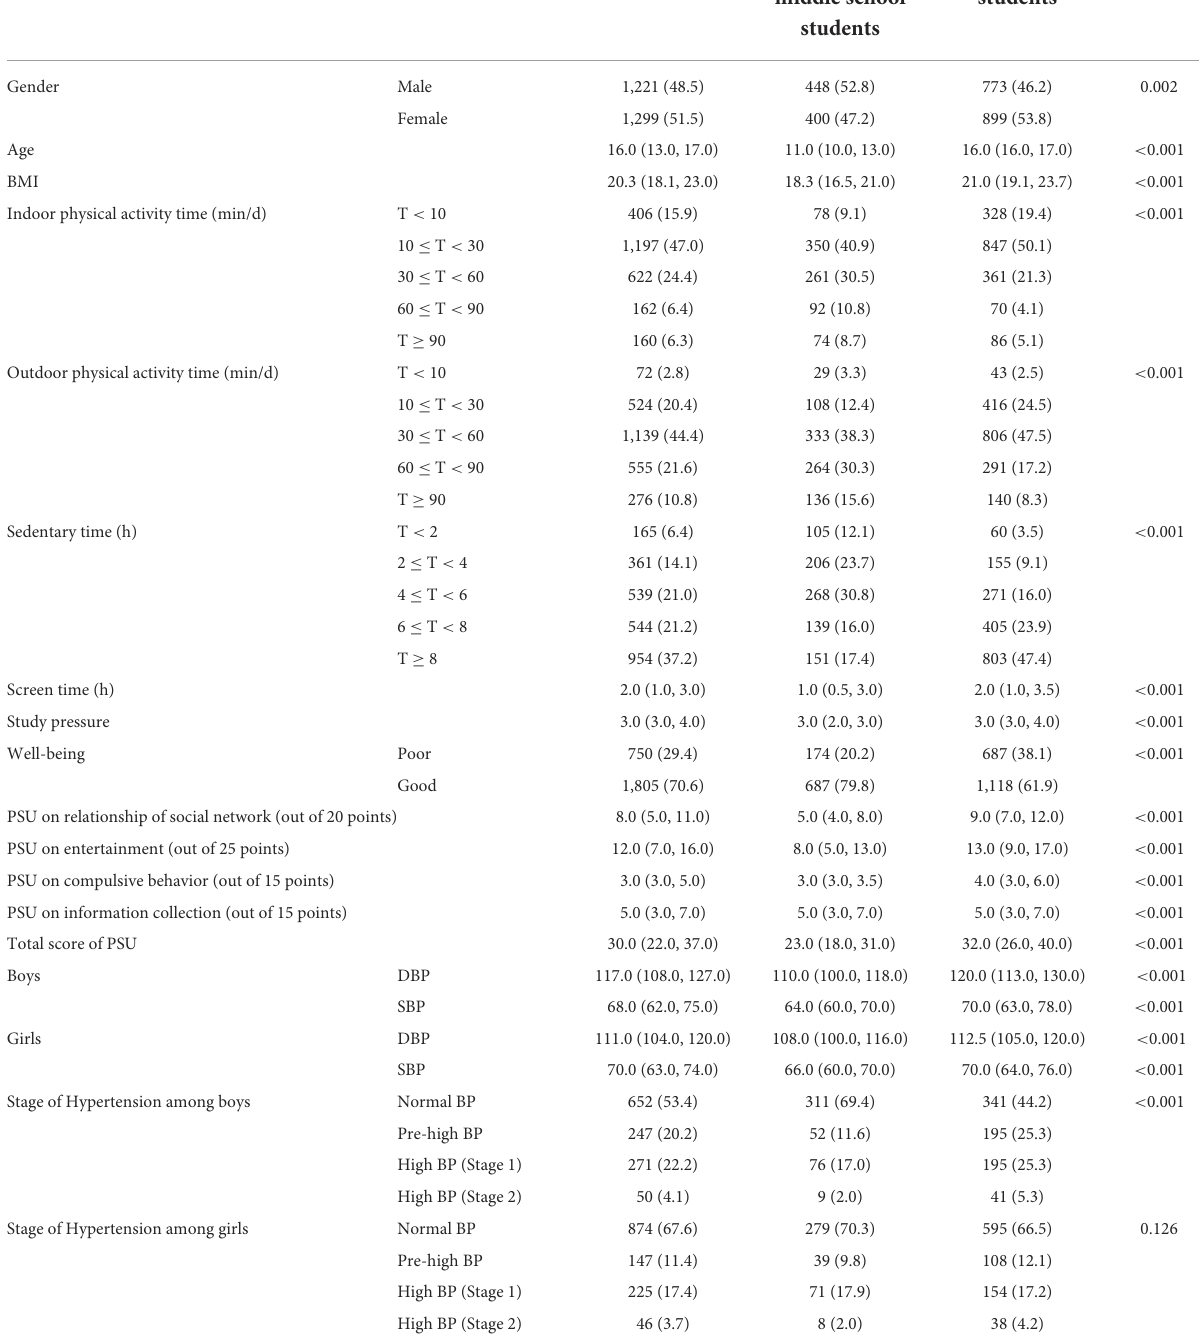
TABLE 1 Comparison of demographics characteristics, PSU, and potential correlates of blood pressure by grade of students [ N (%)/Median (IQR)].